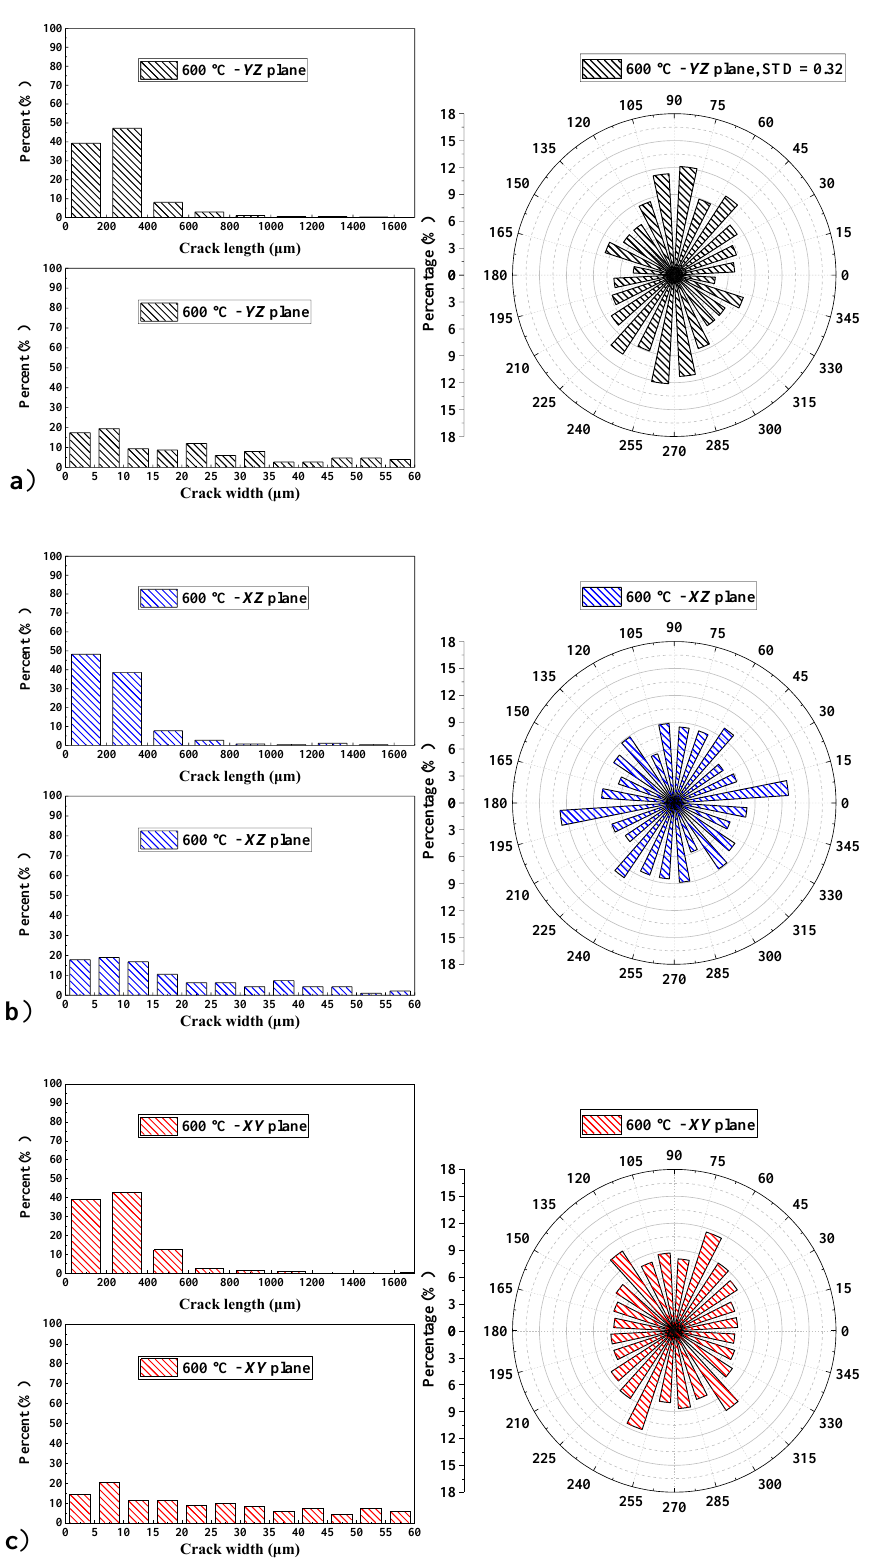
Figure 11. Characteristics of cracks for norite after 600 °C treatment, in ( a ) YZ plane; ( b ) XZ plane; and ( c ) XY plane.